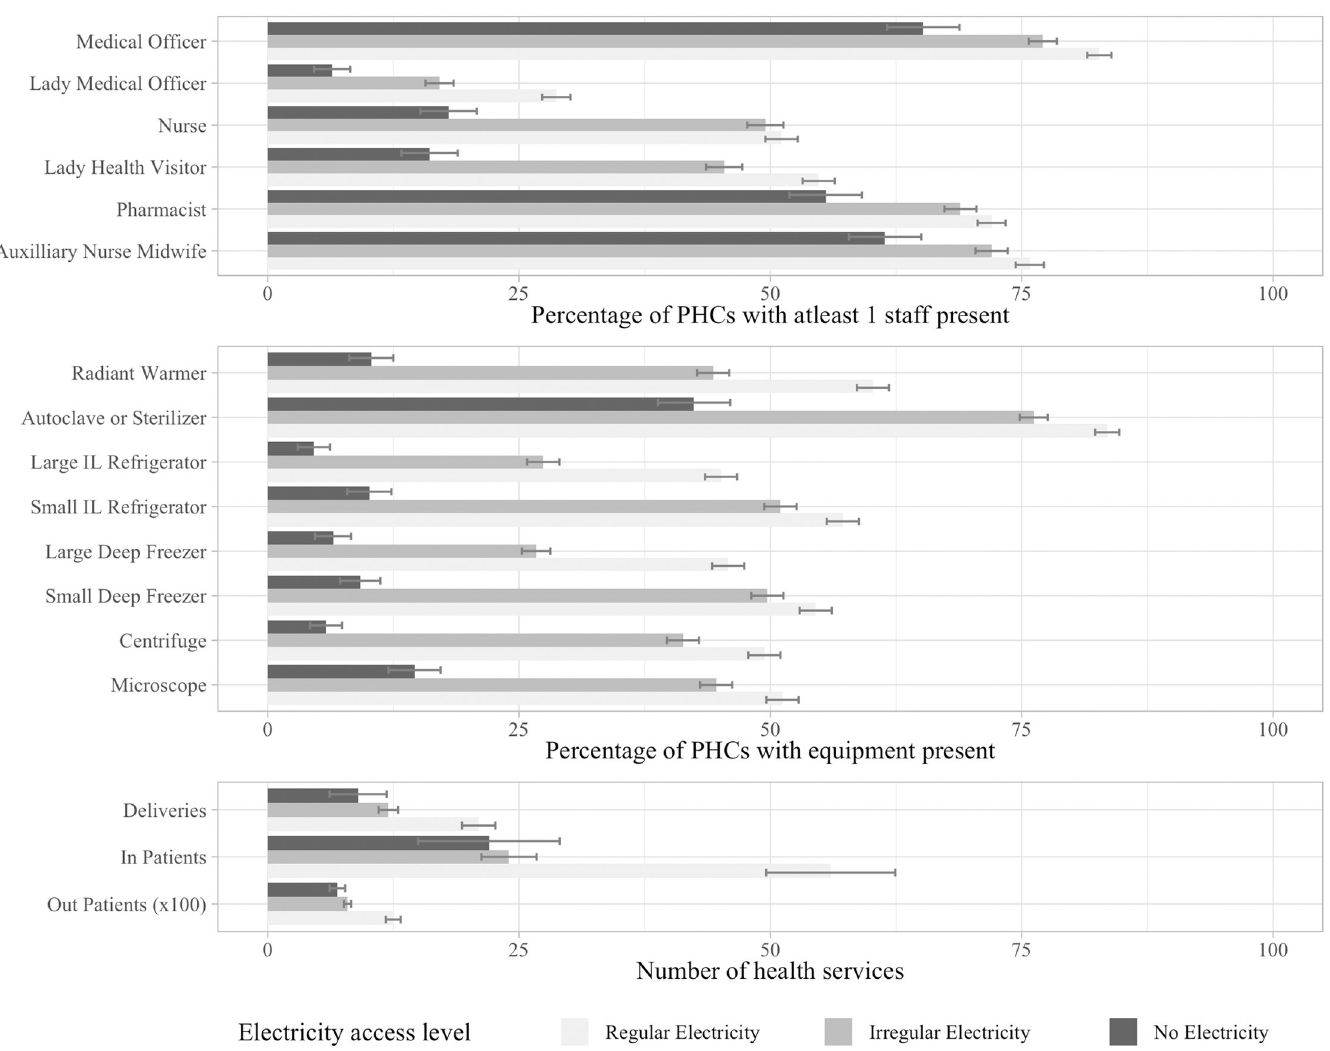
Fig 4. (Top panel) percentage of primary health centers in which medical staff are available, (middle panel) percentage of primary health centers in which functional medical equipment is available, and (bottom panel) average number of patients per month that were treated at the primary health centers, categorized by level of electricity access. Error bars show the 95% confidence interval for each